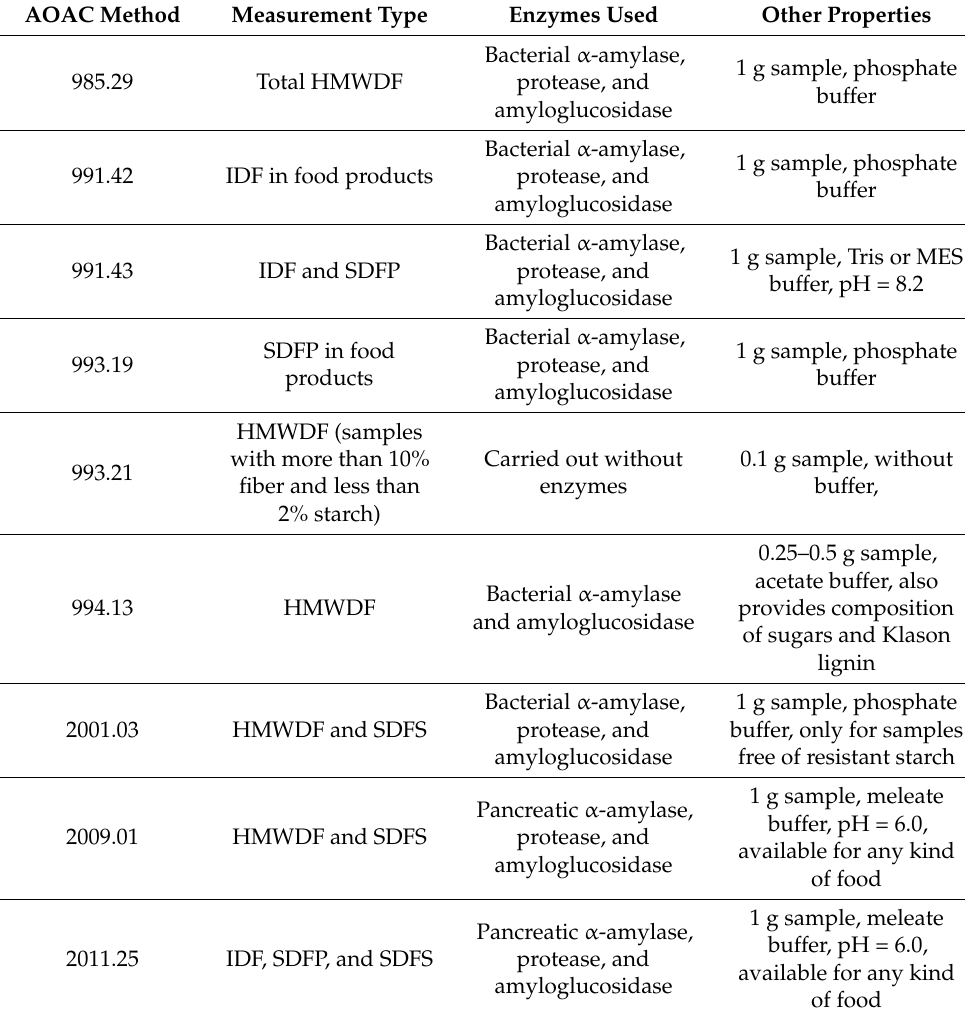
Table 1. Summary of various standard methods used for dietary fiber